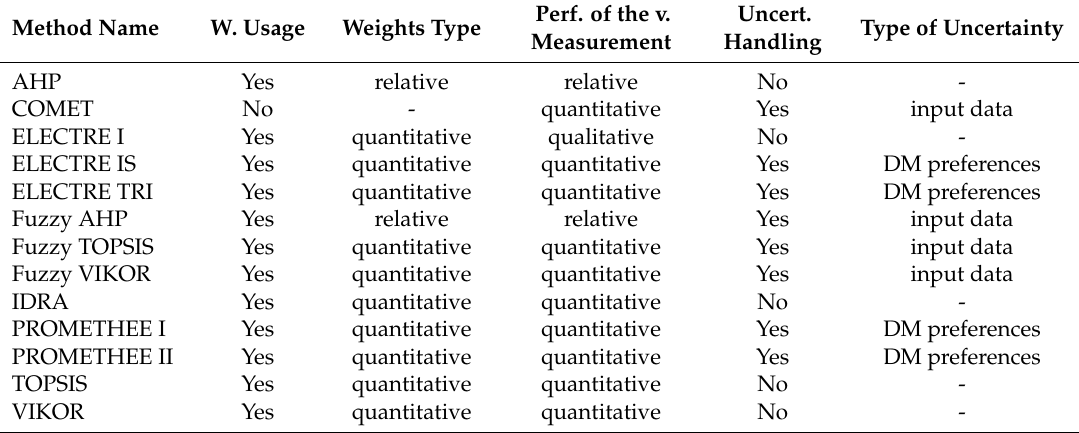
Table 1. Comparison of the Characteristic Objects Method (COMET) with other multi-criteria decision analysis (MCDA)